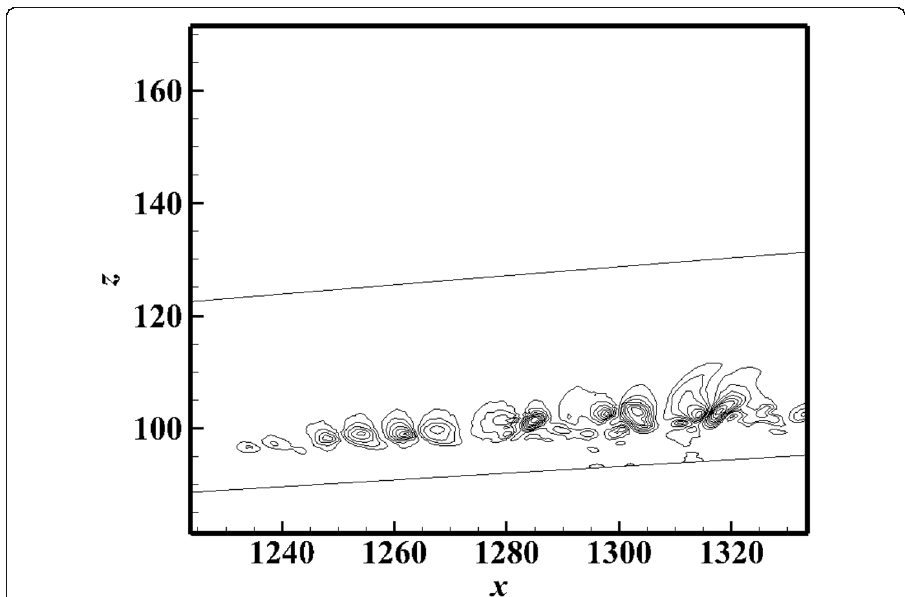
Fig. 14 Instantaneous pressure fluctuations in a streamwise wall-normal plane in zone